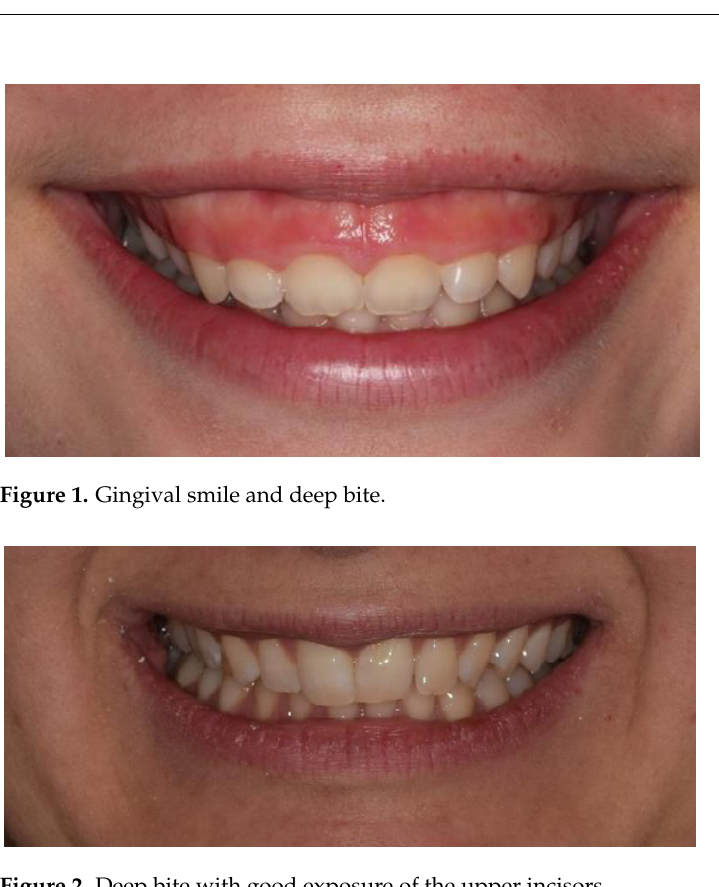
Figure 3. Multibracket appliance during curve of Spee leveling: ( A ) at the beginning of the treat- ment; ( B ) at the end of the treatment.